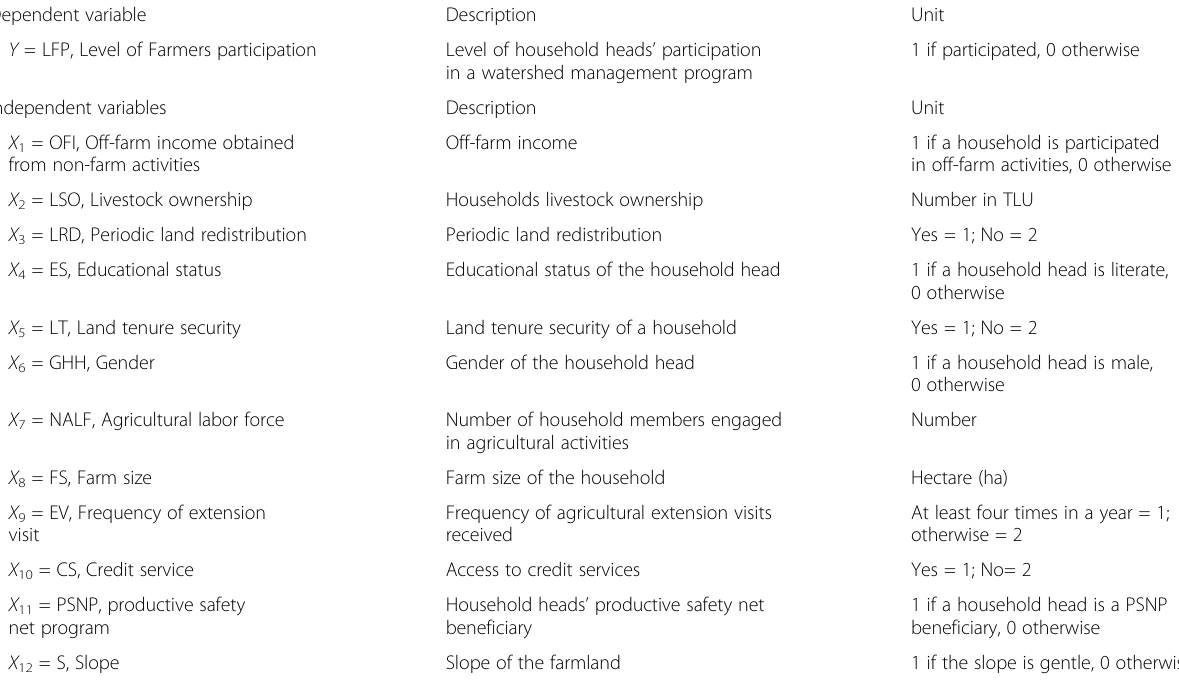
Table 2 Factors influencing the farmers ’ decision to participate in watershed management